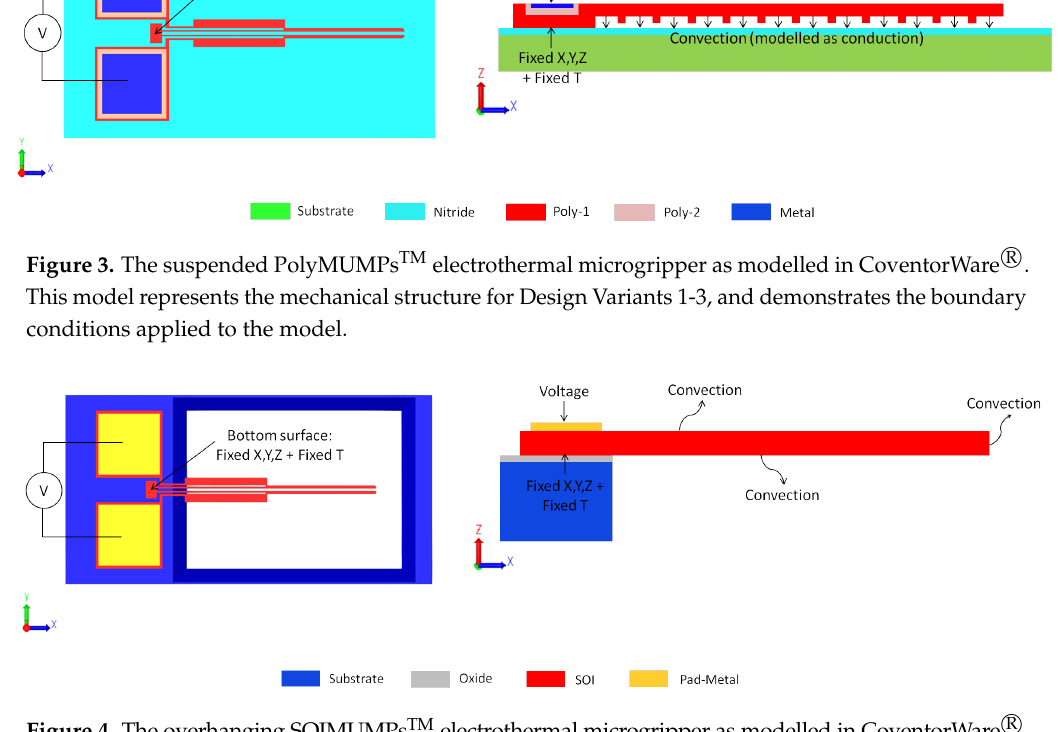
Figure 4. The overhanging SOIMUMPs TM electrothermal microgripper as modelled in CoventorWare R (cid:13) . This model represents the mechanical structure for Design Variant 4, and demonstrates the boundary conditions applied to the